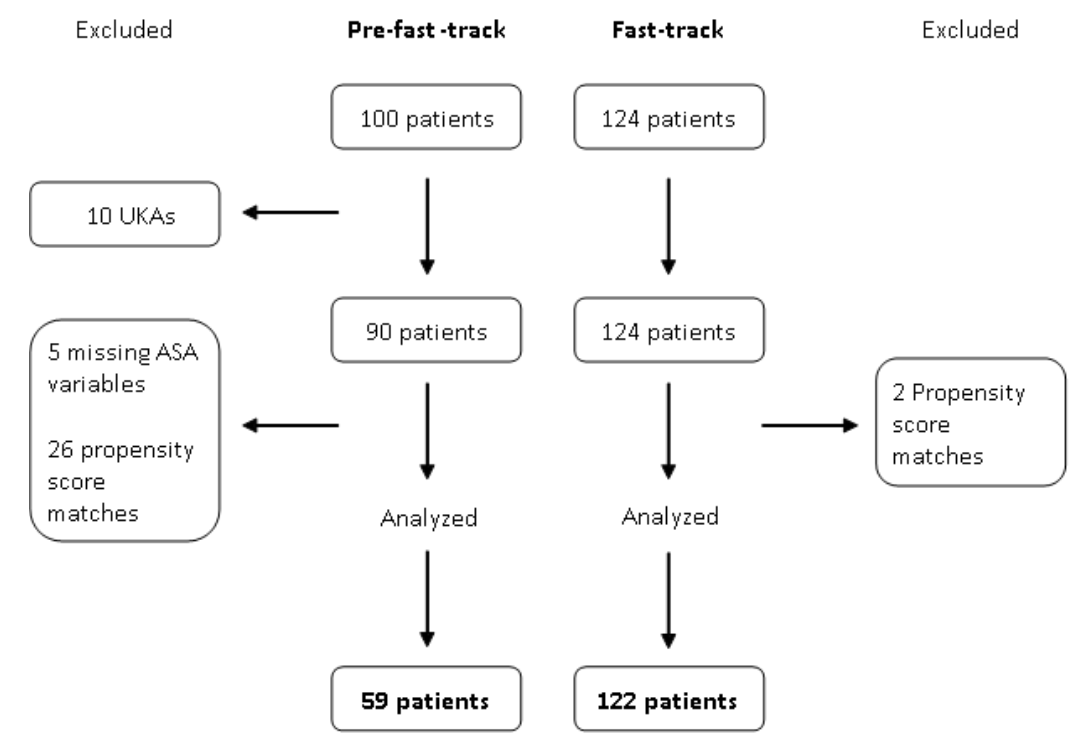
Figure 1. Flow chart reporting the patient selection process. The pre-FT and FT periods corresponded to 2013 – 2014 and 2016, respectively. ASA, American Society of Anesthesiologists; UKA, unicompartmental knee arthroplasty. Table 2. Baseline characteristics of the patients after the propensity score matching.